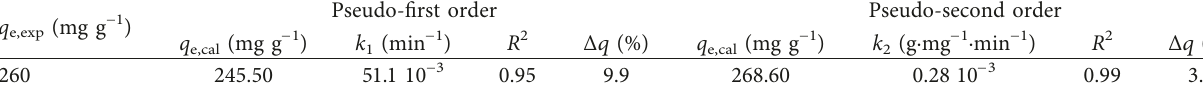
Table 5: Pseudo-first-order and pseudo-second-order kinetics parameters.